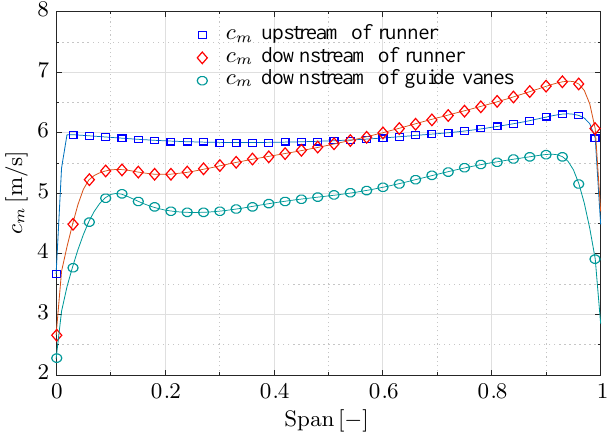
Fig. 14. Distribution of meridional velocity c m upstream and downstream of the runner and downstream of the guide vanes in pumping mode 4) Swirl distribution: The distribution of r